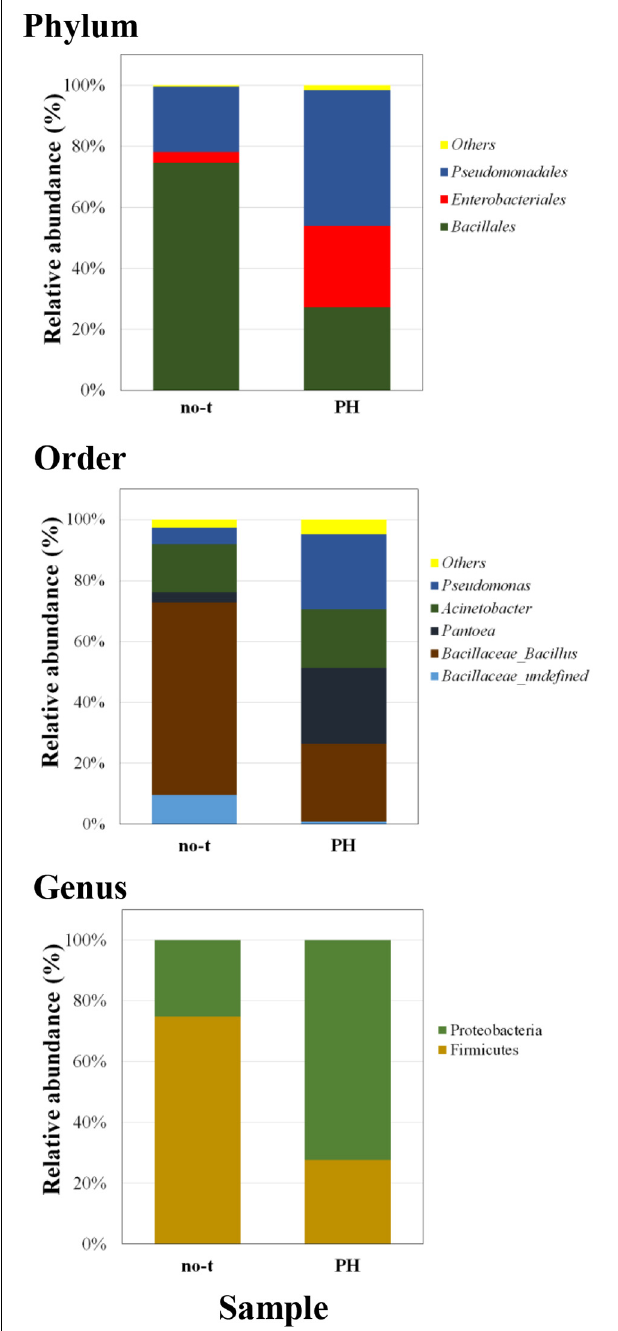
FIGURE 4 | Barplots illustrating the diversity and relative abundances at the phylum, order, and genus levels in PH-treated and no-treated samples collected 1 day after the last treatment. The taxonomy is constructed with the database Silva with a confidence threshold of 97%.